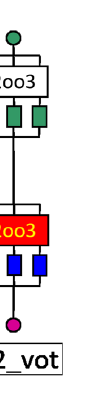
FIG. 15. Case III — Model of C2 interface architecture with error-prone voting (component in red is